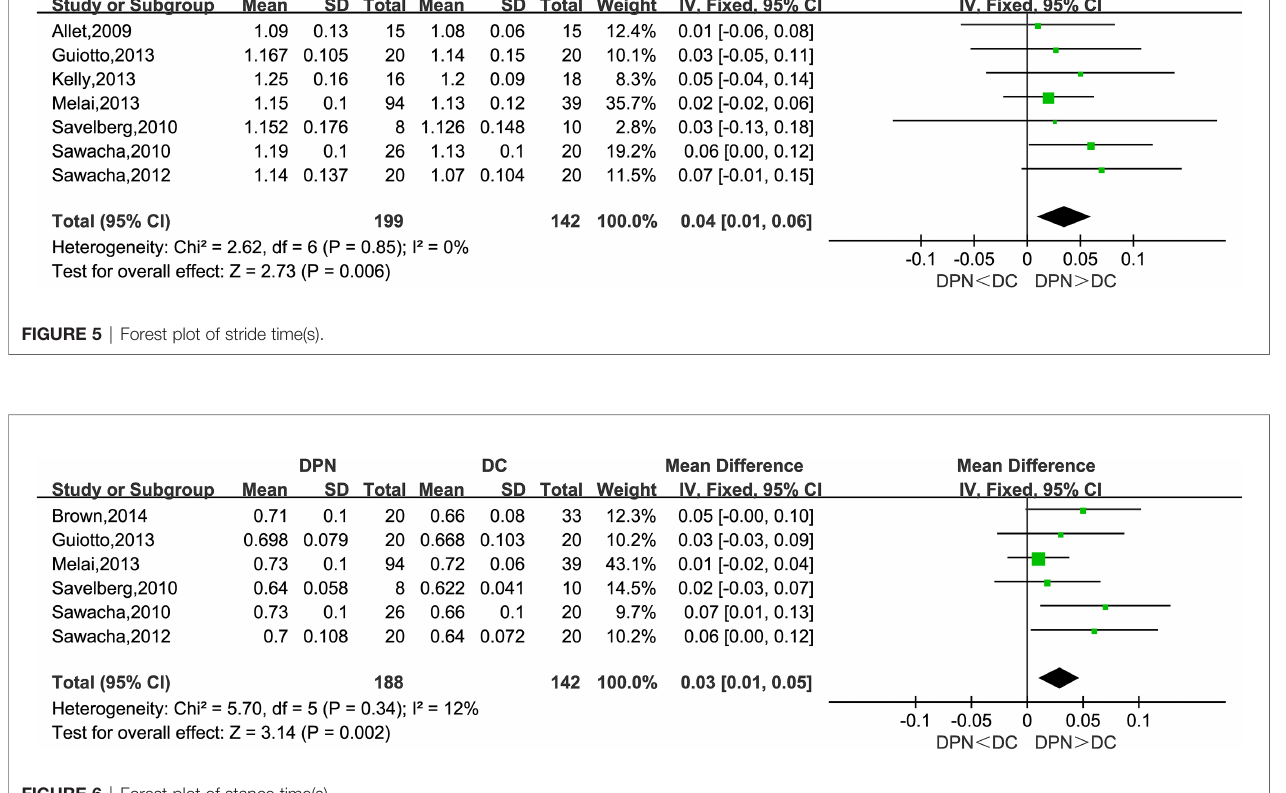
FIGURE 6 | Forest plot of stance